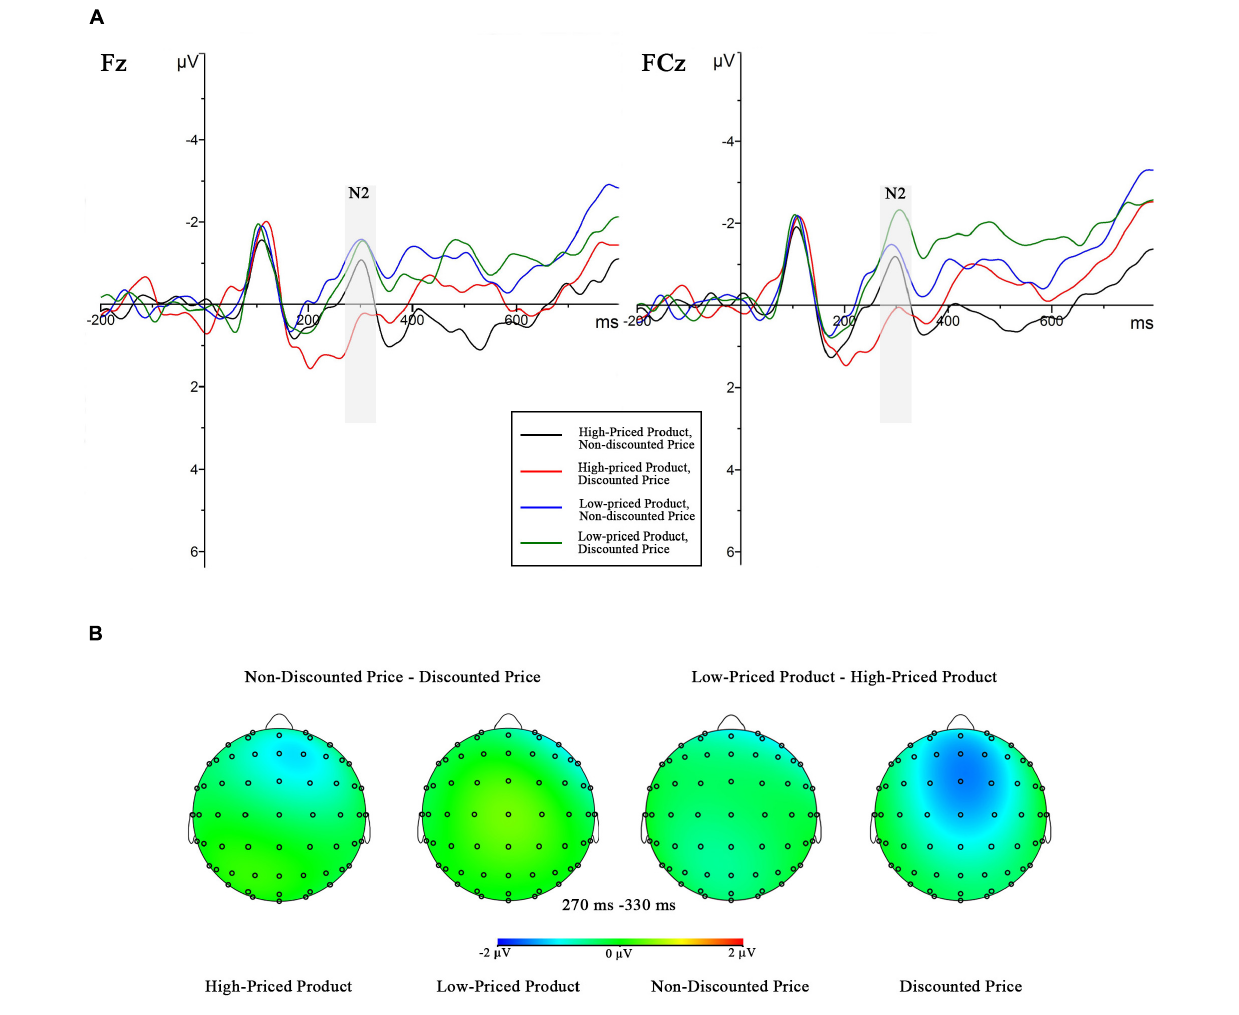
FIGURE 4 | (A) Grand-averaged event-related potential (ERP) waveforms within the N2 time window (270–330 ms) across four conditions (high-priced product with discounted price or with non-discounted price, low-priced product with discounted price or with non-discounted price) with two electrodes (Fz and FCz). (B) Difference maps corresponding to the N2